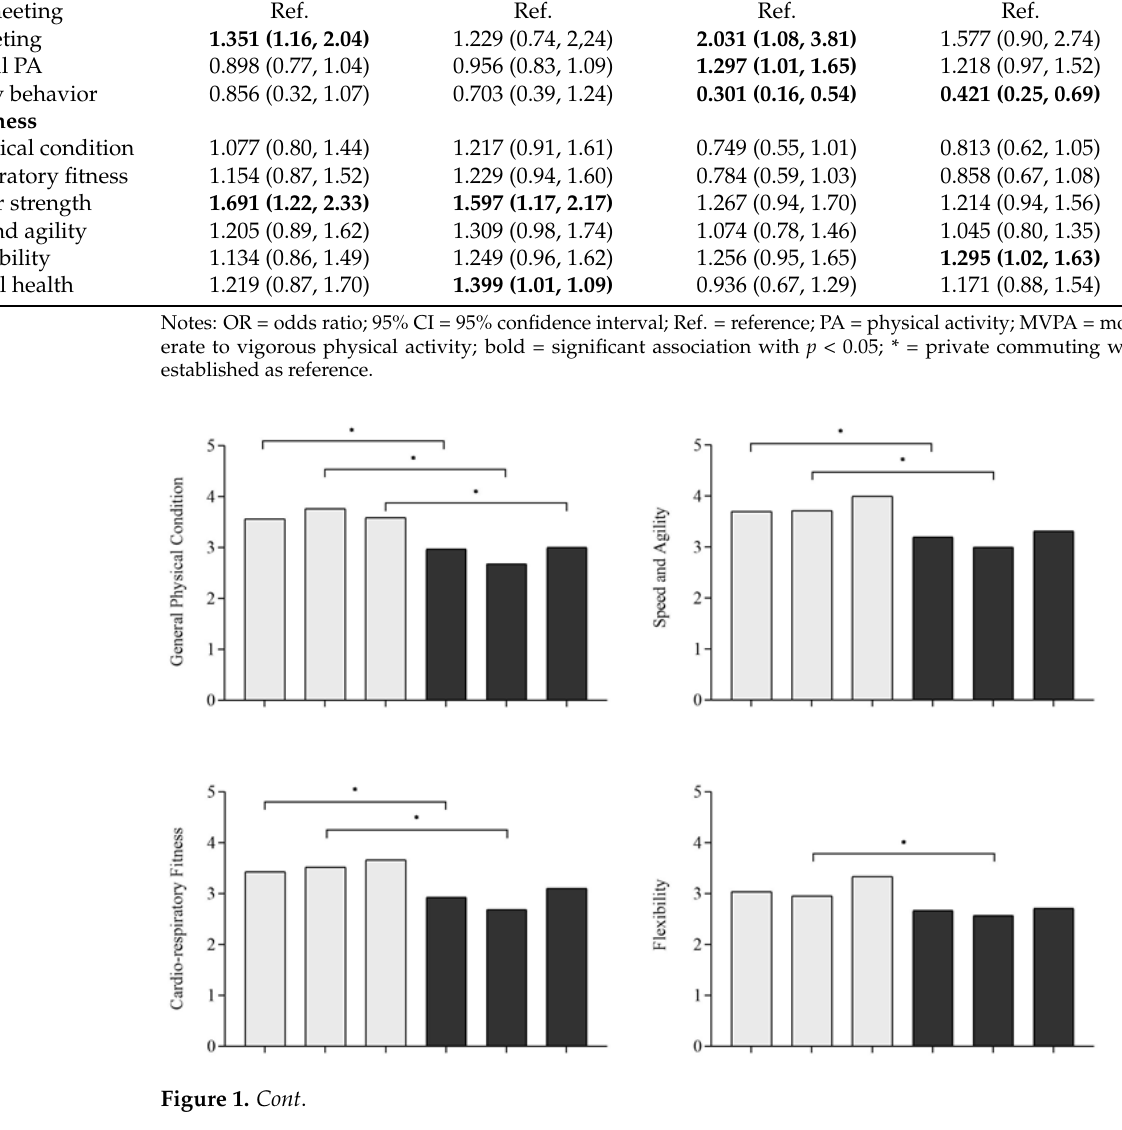
Figure 1. Associations of mode of commuting and meeting MVPA recommendations with fitness in men. Notes: active, public, private = mode of commuting; MVPA = Moderate to Vigorous Physical Activity; Meeting or Not meeting MVPA = MVPA recommendations; * = significant association with p < 0.05 between categorical groups.